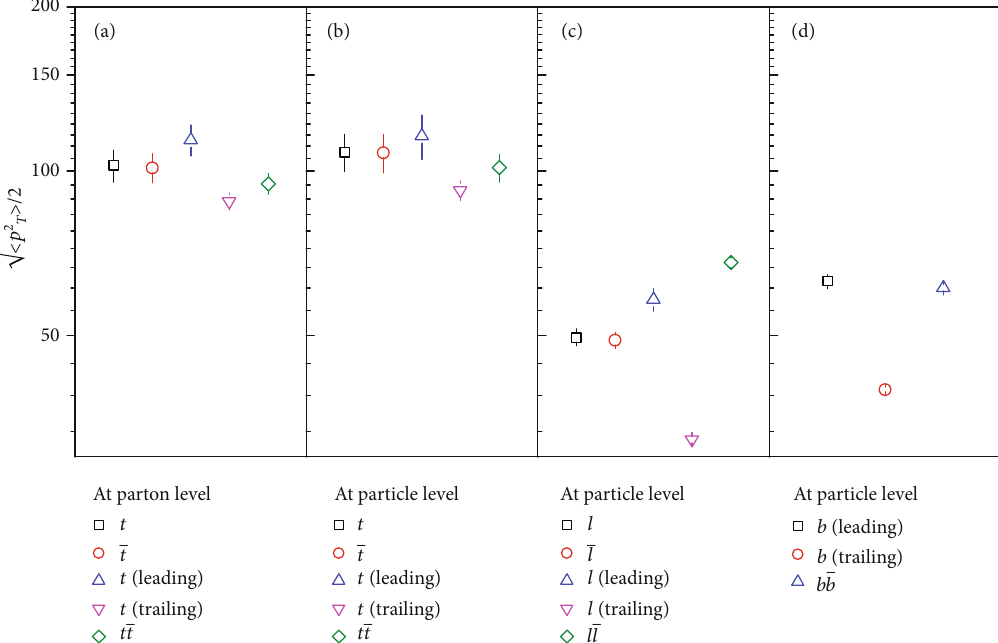
Figure 10: The same as Figure 9 but showing the values of